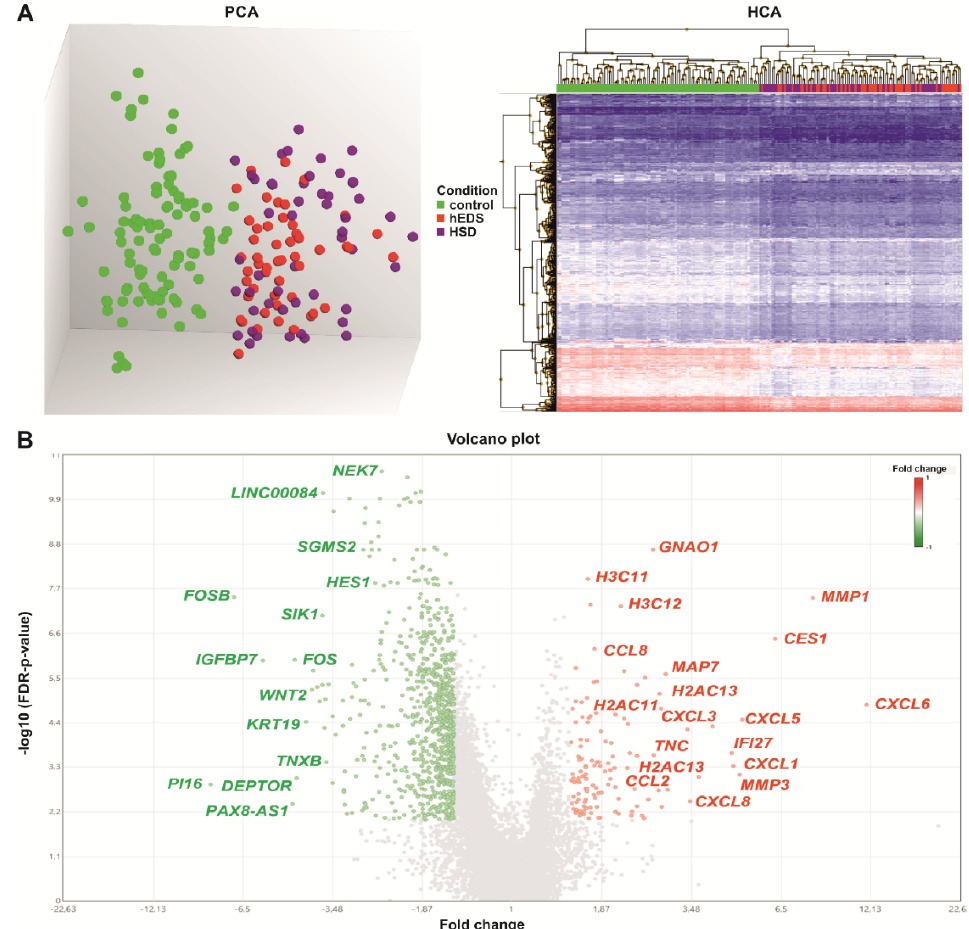
Figure 2. Differential gene expression and functional enrichment analyses. ( A ) On the left, PCA showing a clear distribution of control (green dots), hEDS (red dots), and HSD (violet dots) samples in two distinct clusters. On the right, HCA of the 952 DEGs identified in hEDS/HSD vs. control with downregulated genes in blue and upregulated ones in red. ( B ) Volcano plot displaying the distribution of the 826 downregulated (green) and the 126 upregulated (red) DEGs. The plots represent expression values as fold change ( x -axis) plotted against the -log10 FDR-adjusted p -value ( y -axis). Gene symbols for a selection of DEGs are indicated.